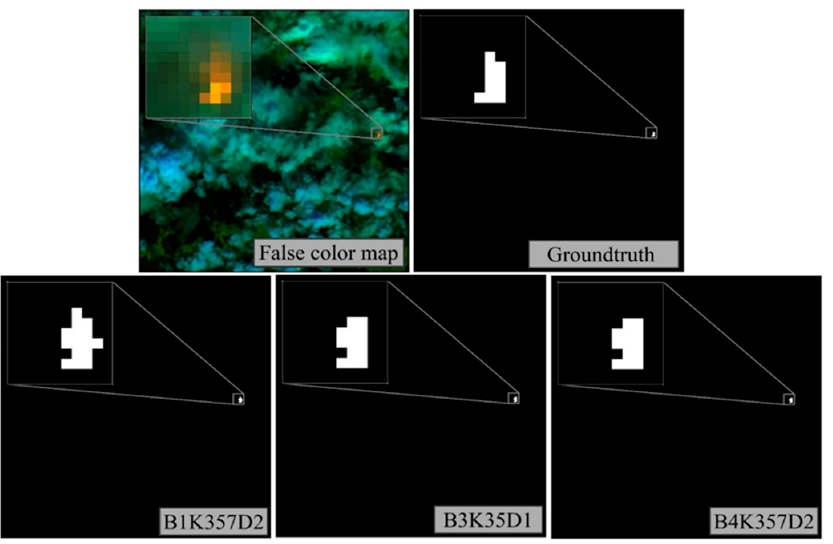
Figure 9. Qualitative comparison between the three best models for AFD in severe cloudy scenes and few fire pixels.